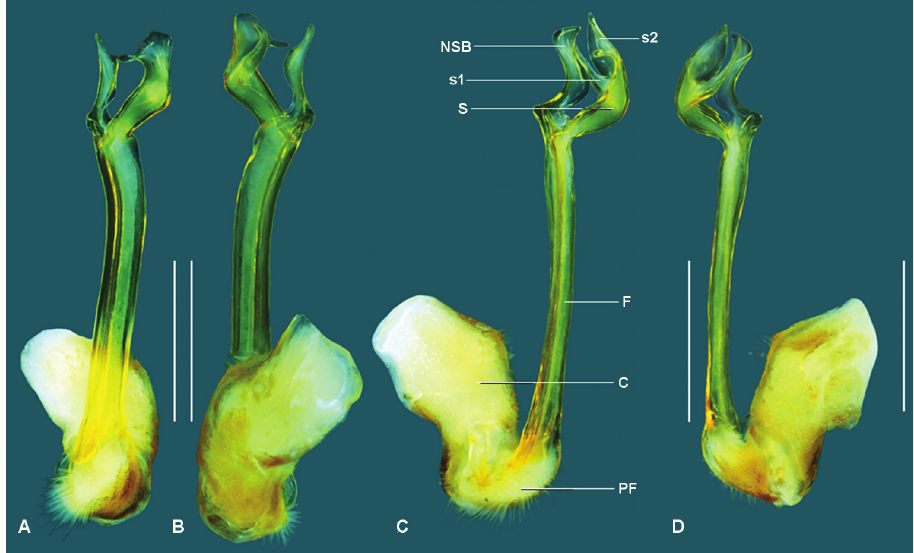
Figure 3. Taxidiotisoma portabile sp. n., holotype male (AM KS. 94041), left gonopod. A posterior B anterior C medial and D lateral views. Abbreviations: C coxa, F femorite, NSB non-seminiferous branch, PF prefemur, S solenomere, s1 process with prostatic groove, s2 cowl-shaped process. Scale bars: 0.5